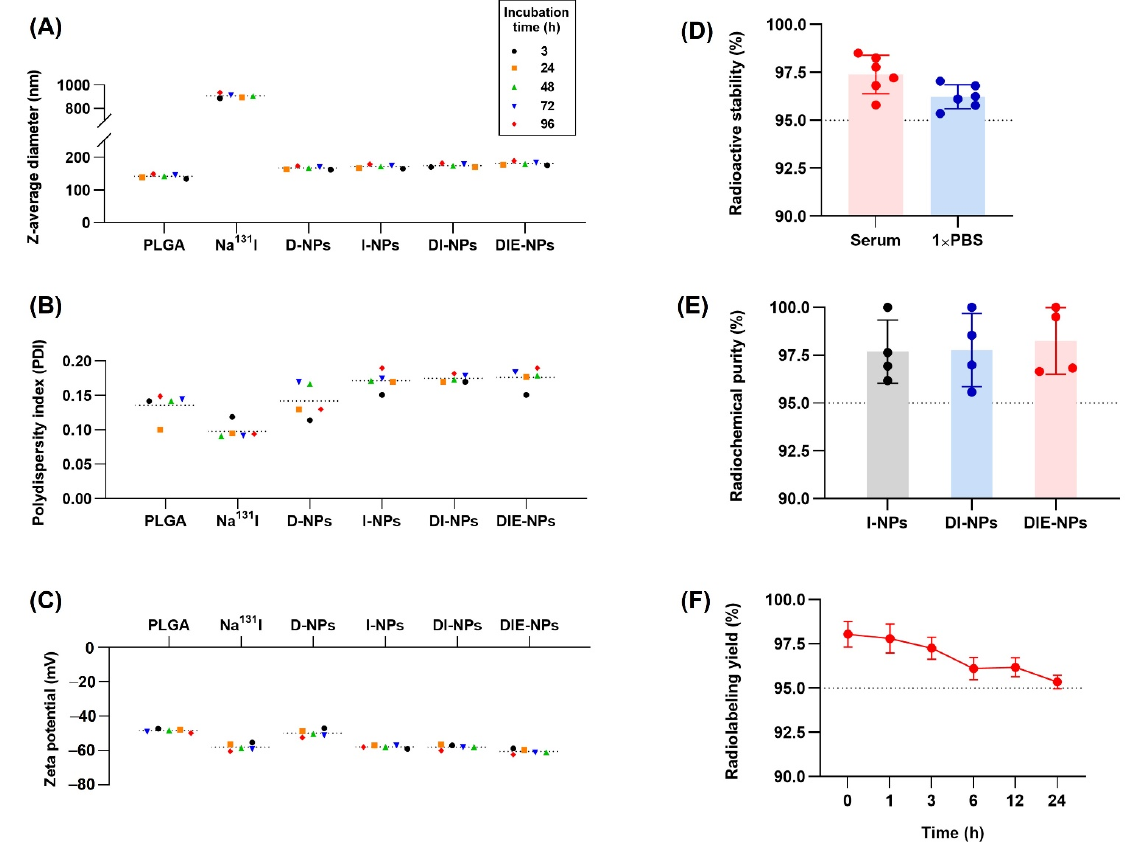
Figure 3. Physiochemical properties and characterization of the nanoparticles after incubation times of 3, 24, 48, 72 and 96 h. ( A ) Z-average diameter (nm). ( B ) Polydispersity index. ( C ) Zeta potential (mV). ( D ) Radioactive stability (%) of DIE-NPs incubated in 20% fetal bovine serum and 1 × PBS over 24 h. ( E ) Radiochemical purity (%) of I-NPs, DI-NPs and DIE-NPs over 96 h. ( F ) Radiolabeling yield of DIE-NPs over 24 h. Data are given as mean ± standard deviation ( n = 3).